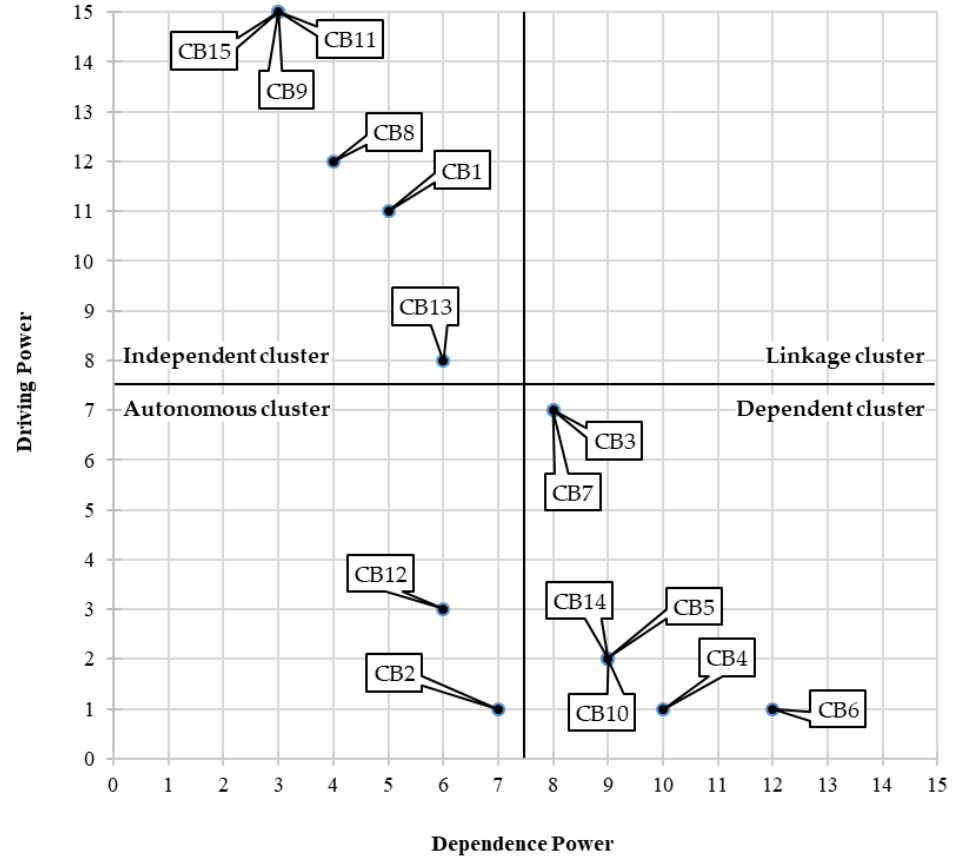
Figure 3. MICMAC analysis for the barriers to the AMC in Portugal.